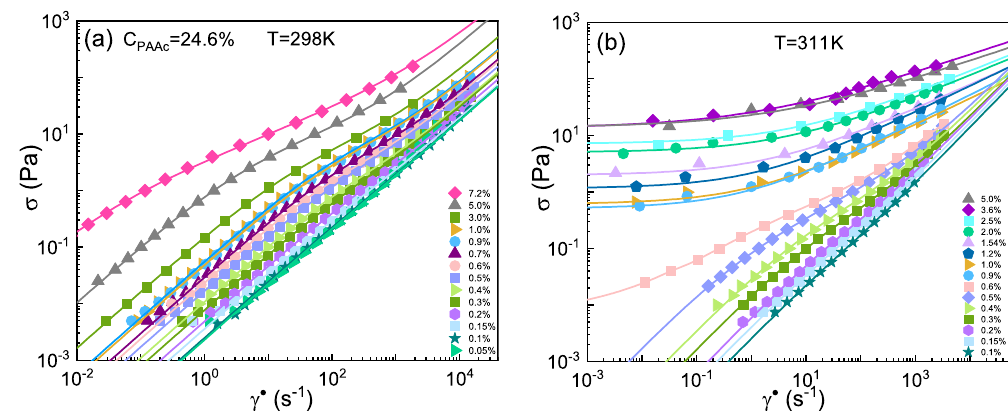
Figure 2. Shear stress σ versus shear rate ˙ γ for IPN microgel with PAAc content 24.6% at different weight concentrations in the range (0.05–7.2)% at ( a ) T = 298K, below the VPT, and ( b ) T = 311K, above the VPT. Lines are fits with the Cross model for low concentrations and with the Herschel-Bulkley model for concentrations showing a yield stress.